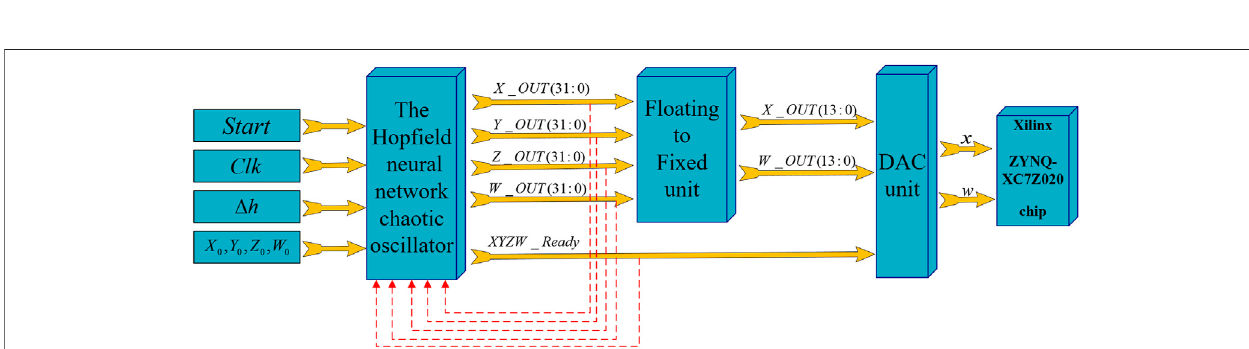
FIGURE 5 | The fl ow block diagram of the FPGA-based Hop fi eld neural network system.